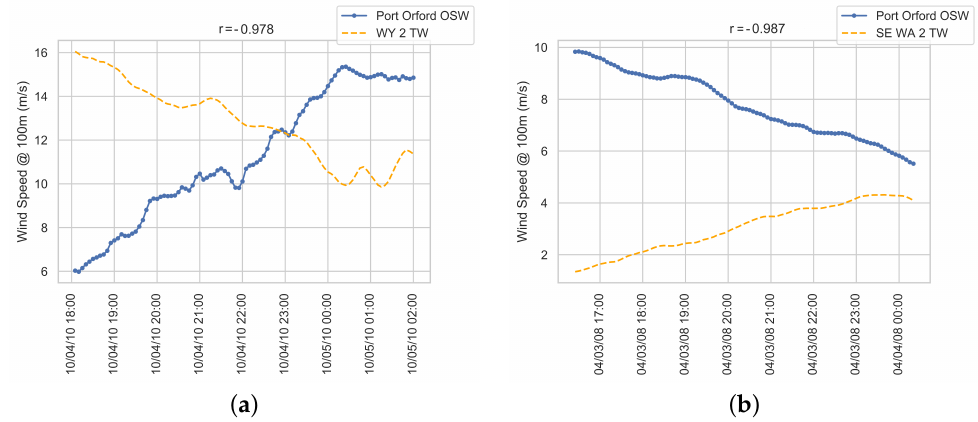
Figure 3. Time series excerpts of high VRE complementarity over 8-h intervals: ( a ) Port Orford OSW increasing as Wyoming land-based, or terrestrial wind (TW), decreases, r = 0.978; ( b ) Washington terrestrial wind rising as production from Port Orford OSW decreases, r =